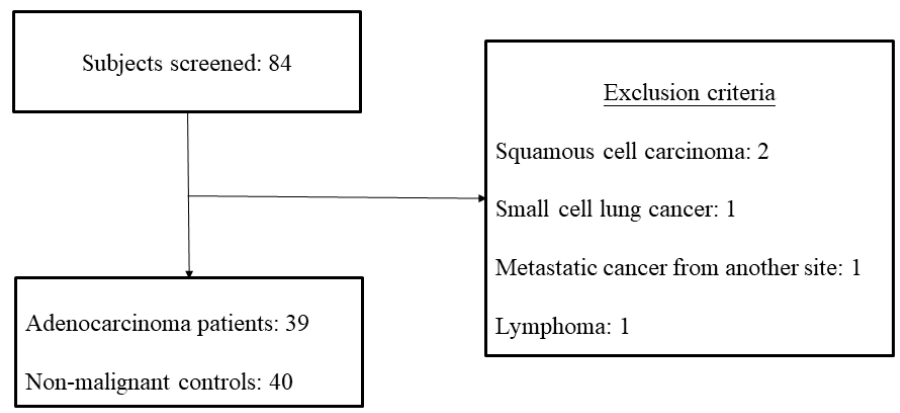
Figure 2. Flow diagram depicting the inclusion and exclusion of the study subjects.